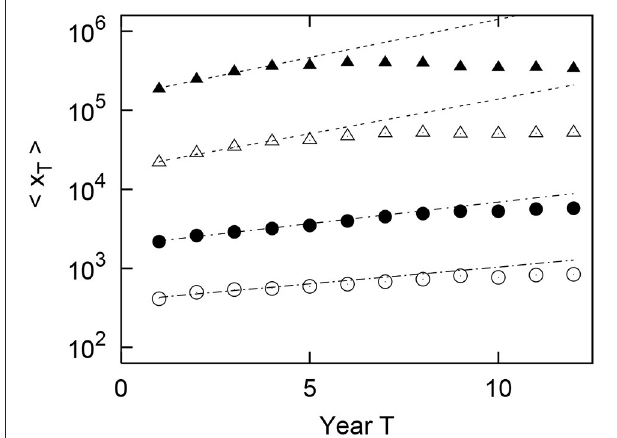
FIGURE 4 | Distributions of urban population growth rates in the United States. The horizontal axis shows the logarithmic growth rate: r = log 10 x i + 10 . The vertical axis shows its conditional probability density x i function: q ( r | n ) . The initial population x i is divided into logarithmically equal